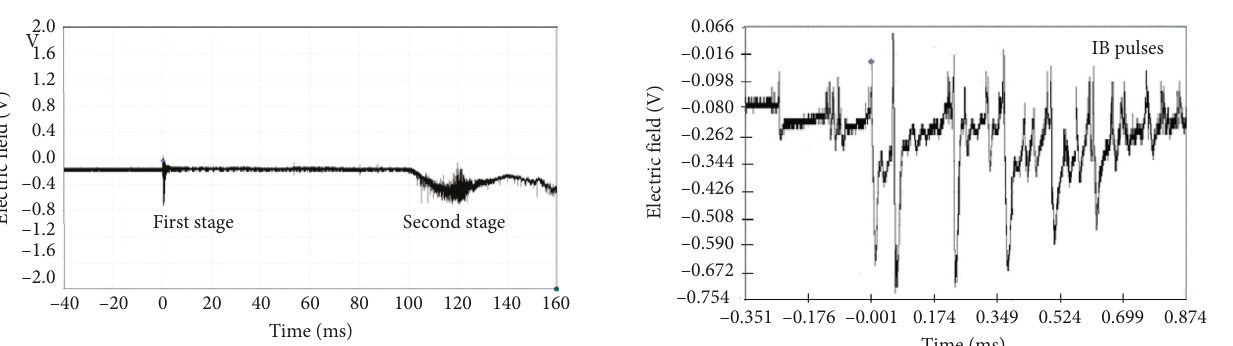
Figure 3: (a) The elevated parallel-plate antenna installed in Kathmandu and (b) the electronic circuit pertinent to buffer amplifier used in this study.